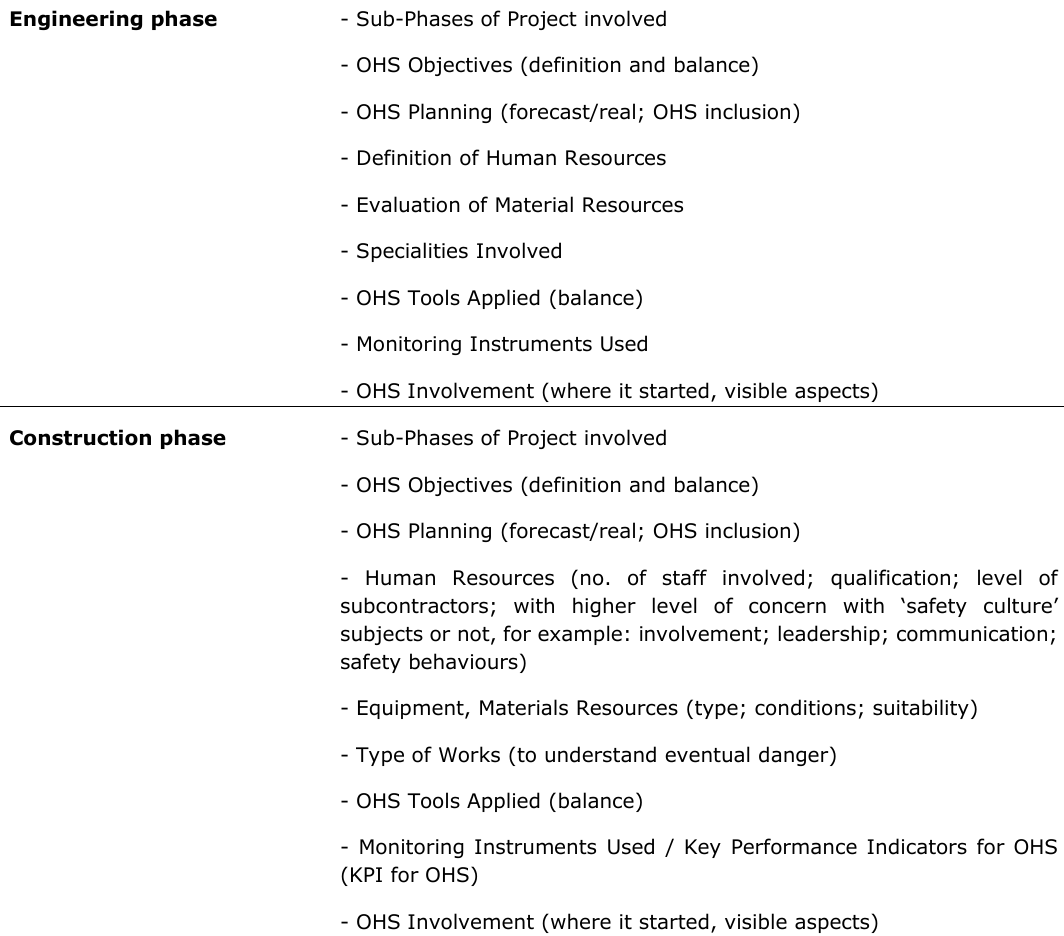
Table 1 . Engineering Phase / Construction Phase (Items/Project) Engineering